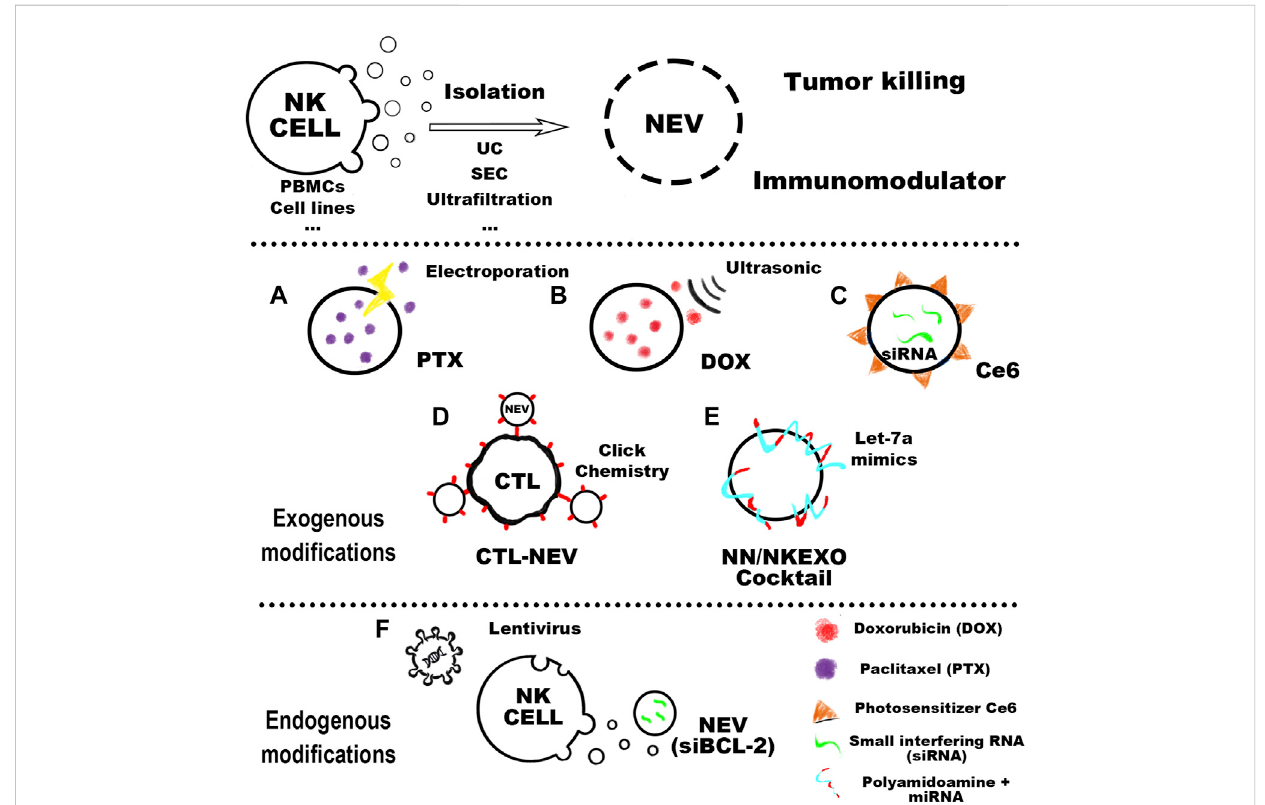
FIGURE 1 The cell sources of NEVs could be mainly divided into peripheral blood mononuclear cells (PBMC) and other cell lines. In the puri fi cation process of NEVs, the more mature isolation methods include ultracentrifugation (UC), ultra fi ltration, and size exclusion chromatography (SEC). Puri fi ed NEVs have anti-tumor activity and immunomodulatory effects, and engineered modi fi cations can confer new functions on NEVs. Common NEVs engineering techniques can be classi fi ed as exogenous and endogenous modi fi cations. Exogenous modi fi cations: (A) NEVs can be used to prepare the PTX- NEVs drug delivery system through electroporation (Han et al., 2020). (B) The therapeutic potential of doxorubicin-loaded NEVs shows promising antitumor activity in vivo against the MCF-7 induced tumor model (Pitchaimani et al., 2018). (C) Light-activatable silencing NK-derived exosomes (LASNEO) are orchestrated by engineering the NEVs with hydrophilic small interfering RNA (siRNA) and hydrophobic photosensitizer Ce6 (Zhang et al., 2022). (D) NEVs are used as a versatile toolkit to synergistically improve adoptive T-cell therapy for solid tumors (Nie et al., 2021). (E) NEVs are